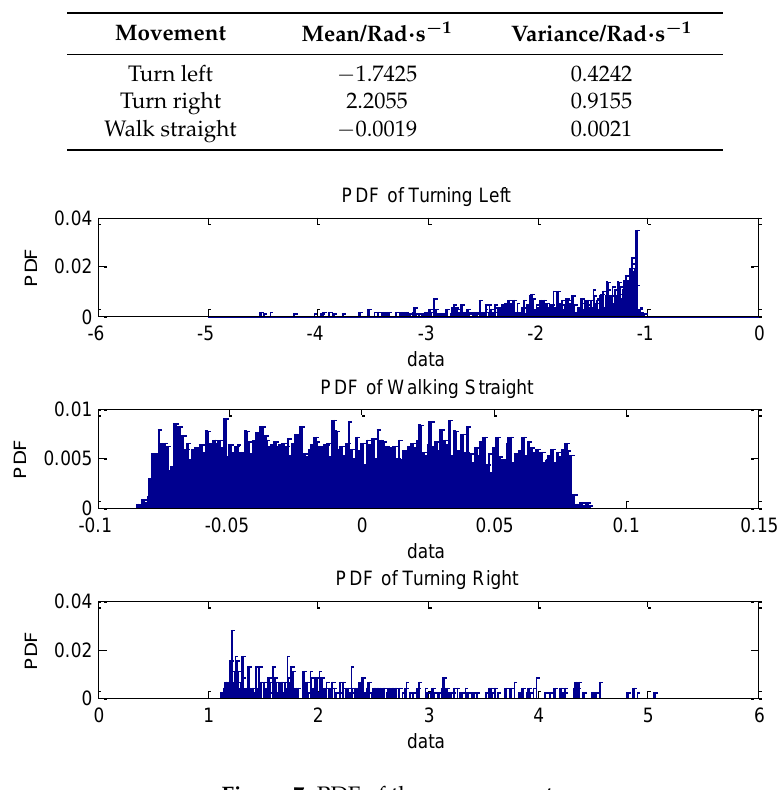
Figure 7. PDF of three movements. Table 2. The parameters of the sensors on the XiaoMi 3 smartphone.